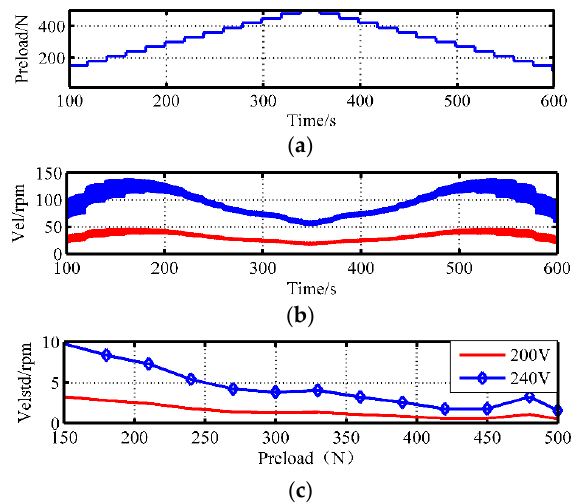
Figure 6. The speed stability under different preload forces: ( a ) staircase preloads; ( b ) output speed; ( c ) speed variance.